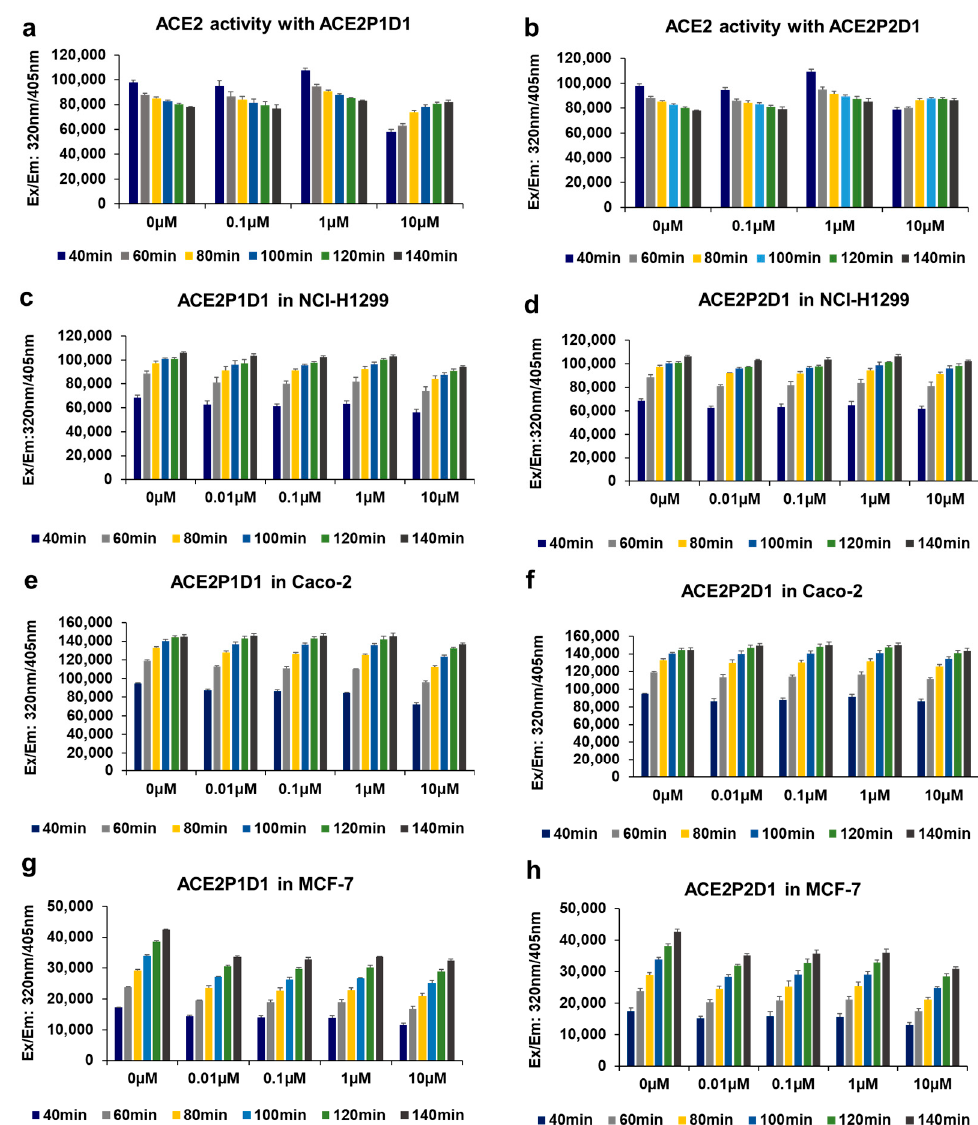
Figure 4. ACE2P1D1 and ACE2P2D1 do not affect the enzymatic activity of ACE2. ( a , b ) Assays were run at 37 °C in ACE2 reaction buffer containing 10 µM Mca-YVADAPK(Dnp) with 0.1 µg of ACE2 protein and various concentrations of ACE2P1D1 and ACE2P2D1. Fluorescence (excitation 320 nm and emission 405 nm) was measured in a microplate reader. Cleavage of the substrate by ACE2 enzyme produces fluorescence, which indicates ACE2 enzymatic activity. ( c – h ) Human cell lines NCI-H1299, Caco-2, and MCF-7 were treated with various concentrations of ACE2P1D1 or ACE2P2D1, in the presence of cOmplete™ Protease Inhibitor Cocktail (40 µL/mL) and 10 µM captopril. ACE2 activity was measured as described in ( a , b ), using 40 µg of cell lysate per each cell line. Each bar represents the mean + standard deviation ( n = 3/group).